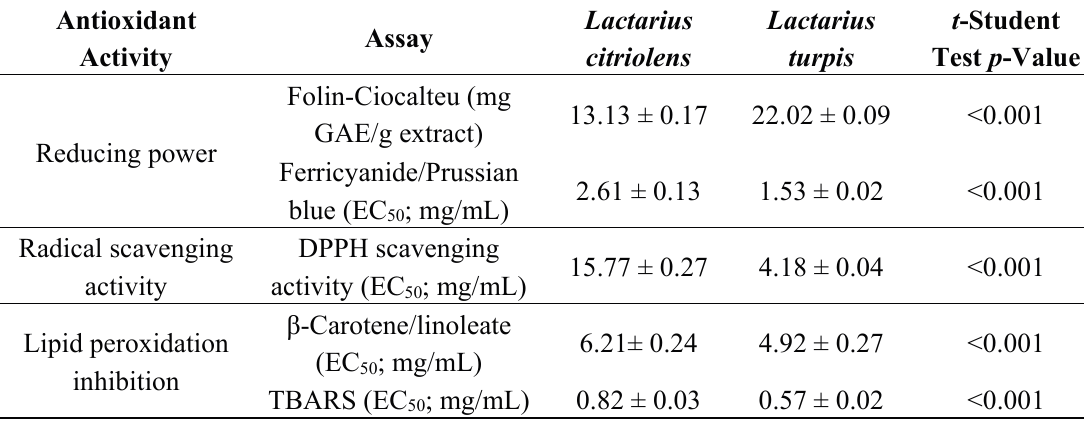
Table 3. Antioxidant activity of the methanolic extracts (mean ±